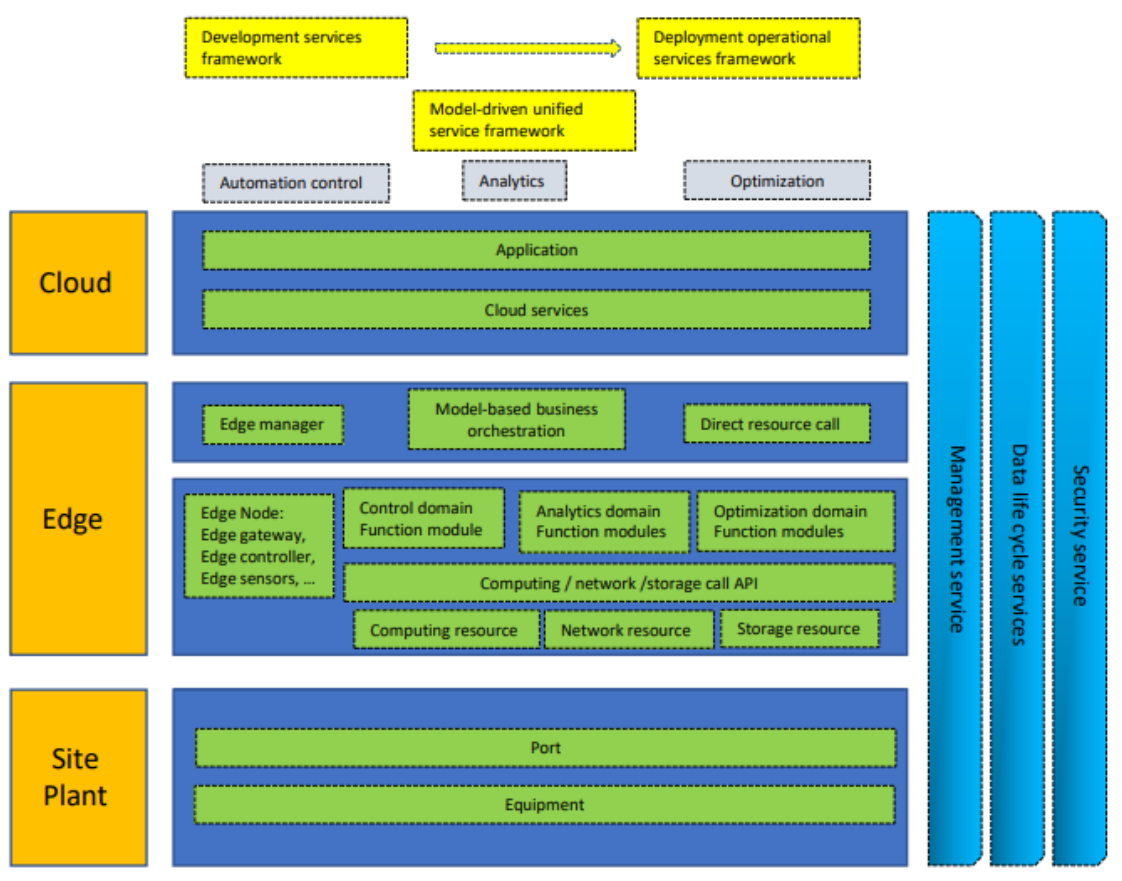
Figure 1. Edge computing reference architecture